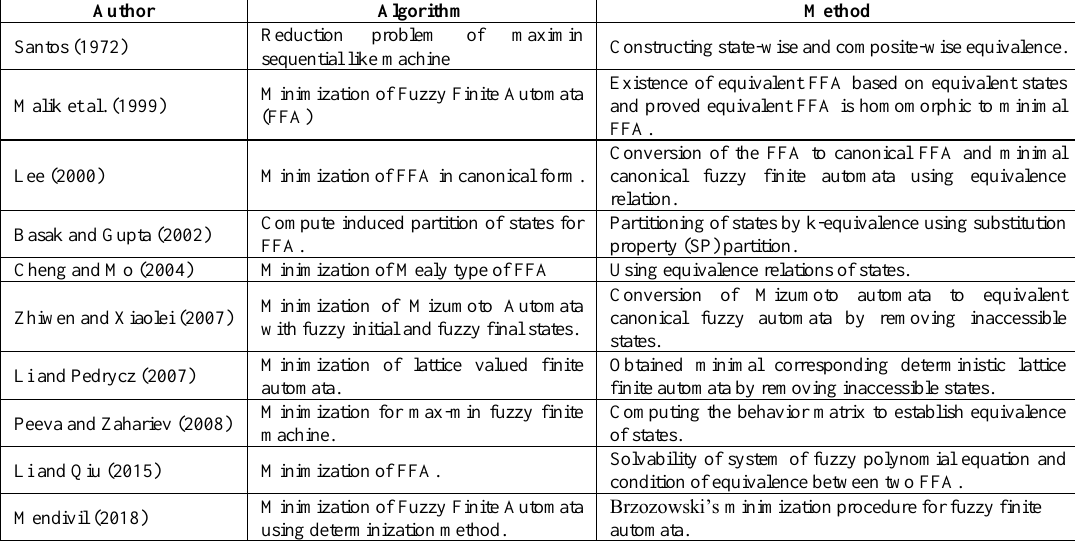
Table 1. Summary of minimization algorithms for fuzzy finite